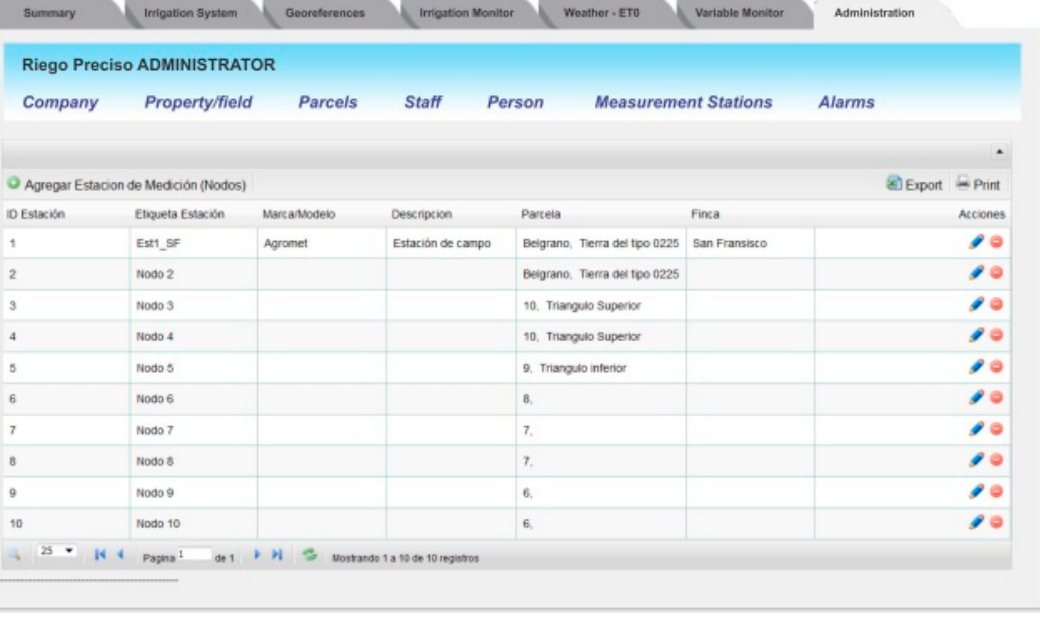
Figure 9. The Administration tab allows the system administrator to configure different parameters of the monitoring and control system.